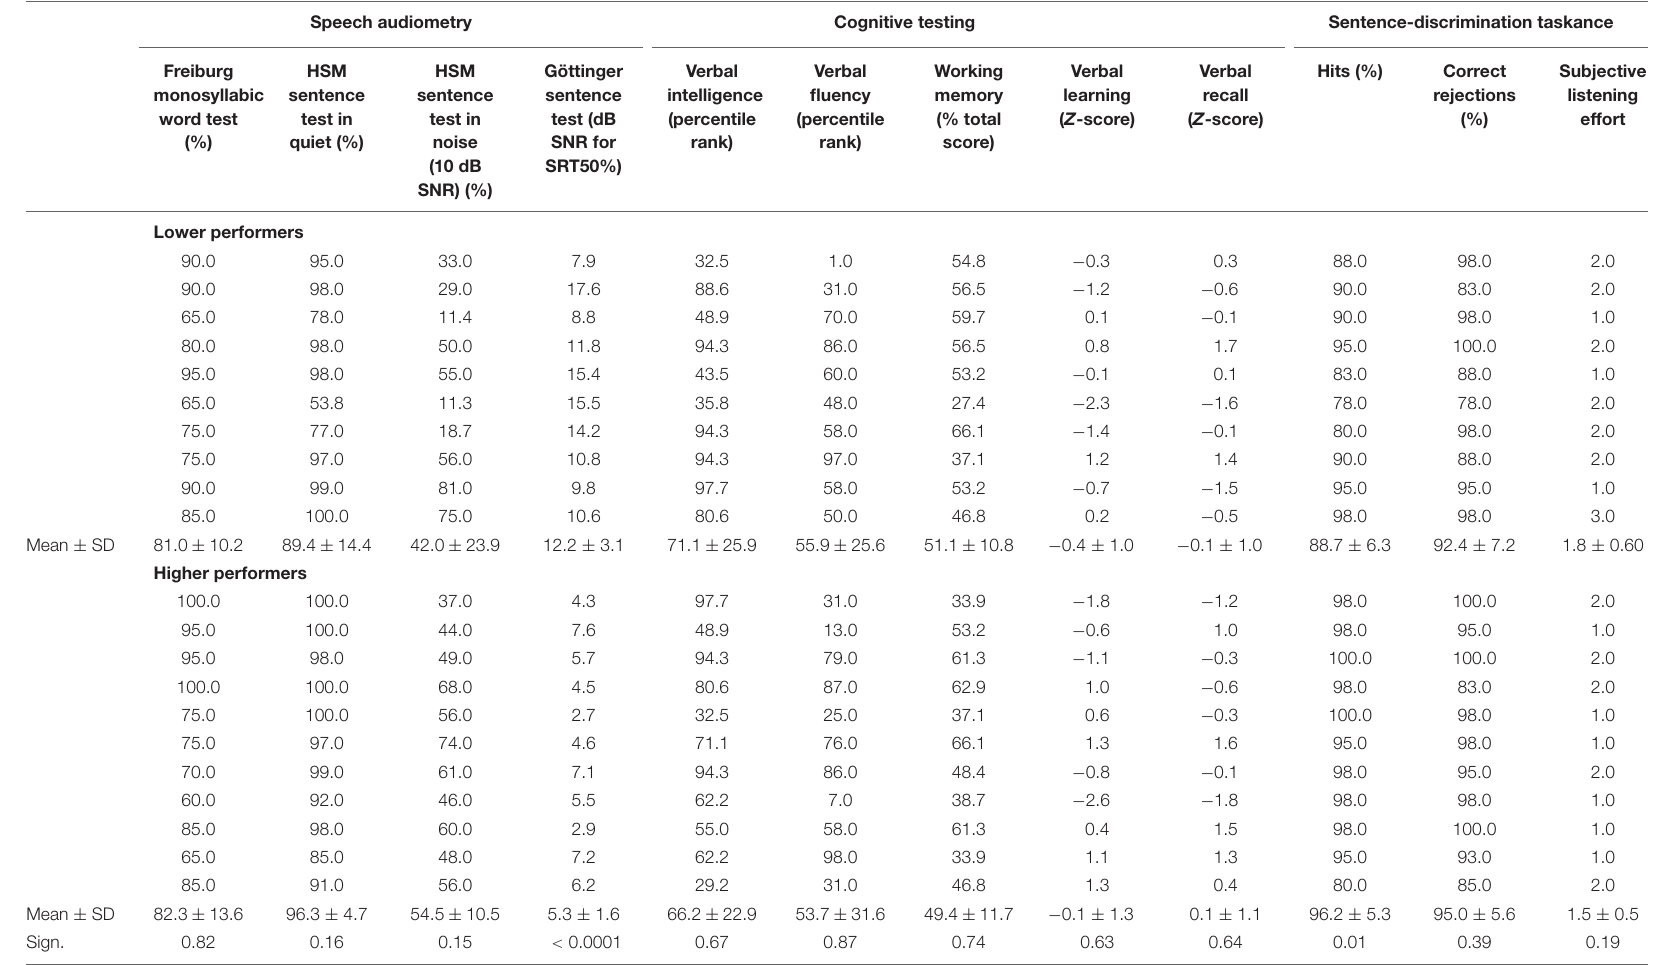
TABLE 2 | Results of speech audiometry, cognitive tests, and sentence-discrimination task during EEG